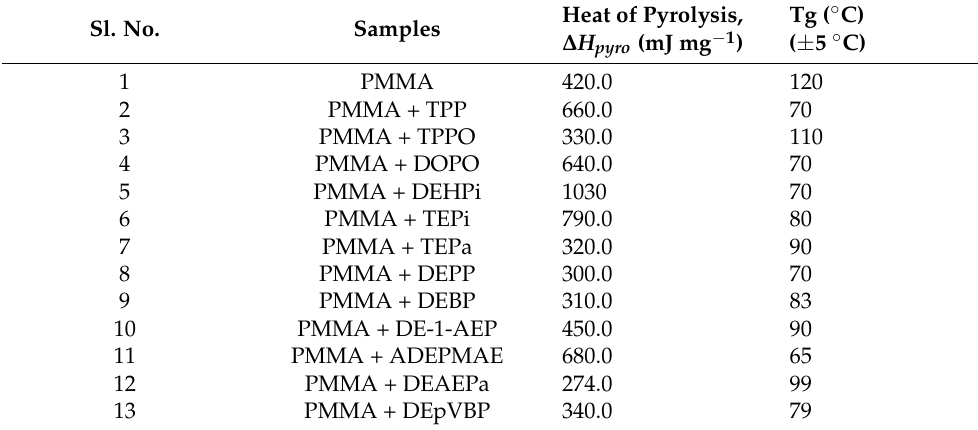
Table 5. Heat of pyrolysis data of PMMA-based materials obtained from DSC tests. Sl.